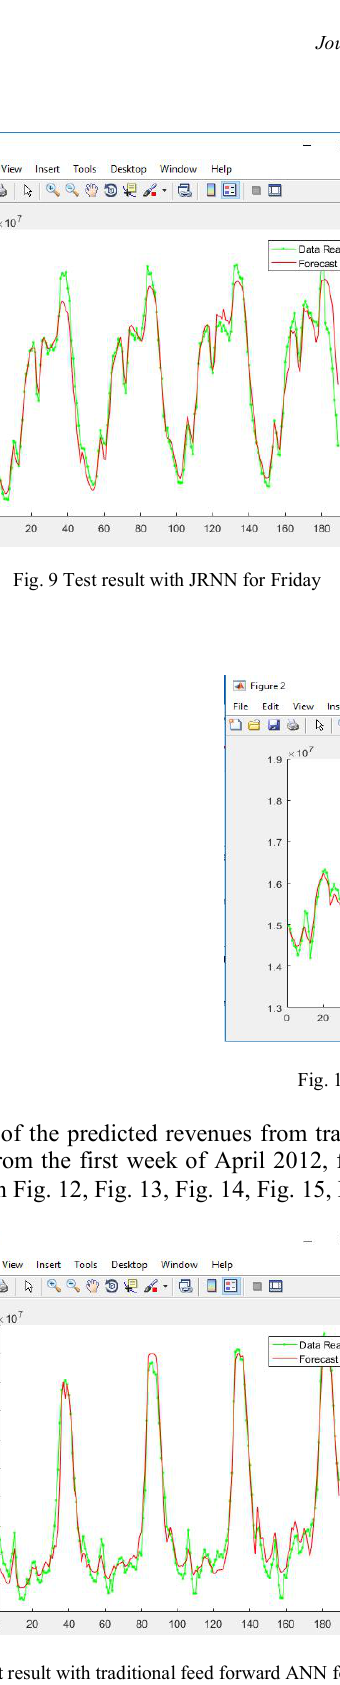
Fig. 13 Test result with traditional feed forward ANN for